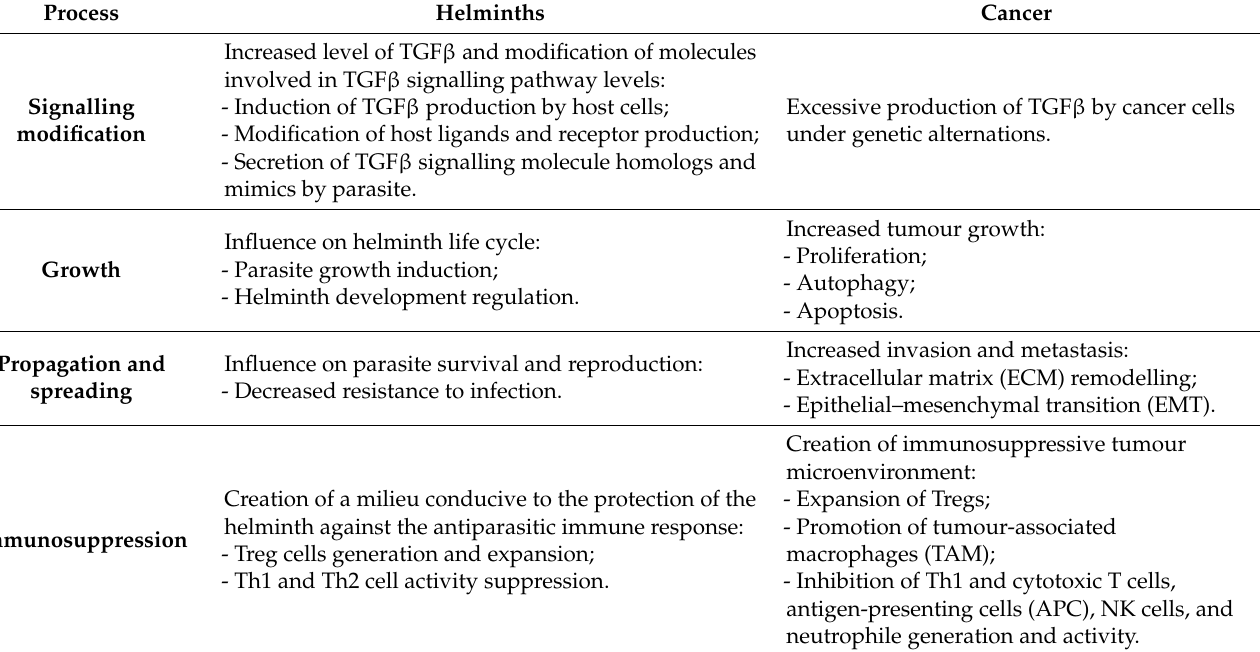
Excessive production of TGF β by cancer cells under genetic